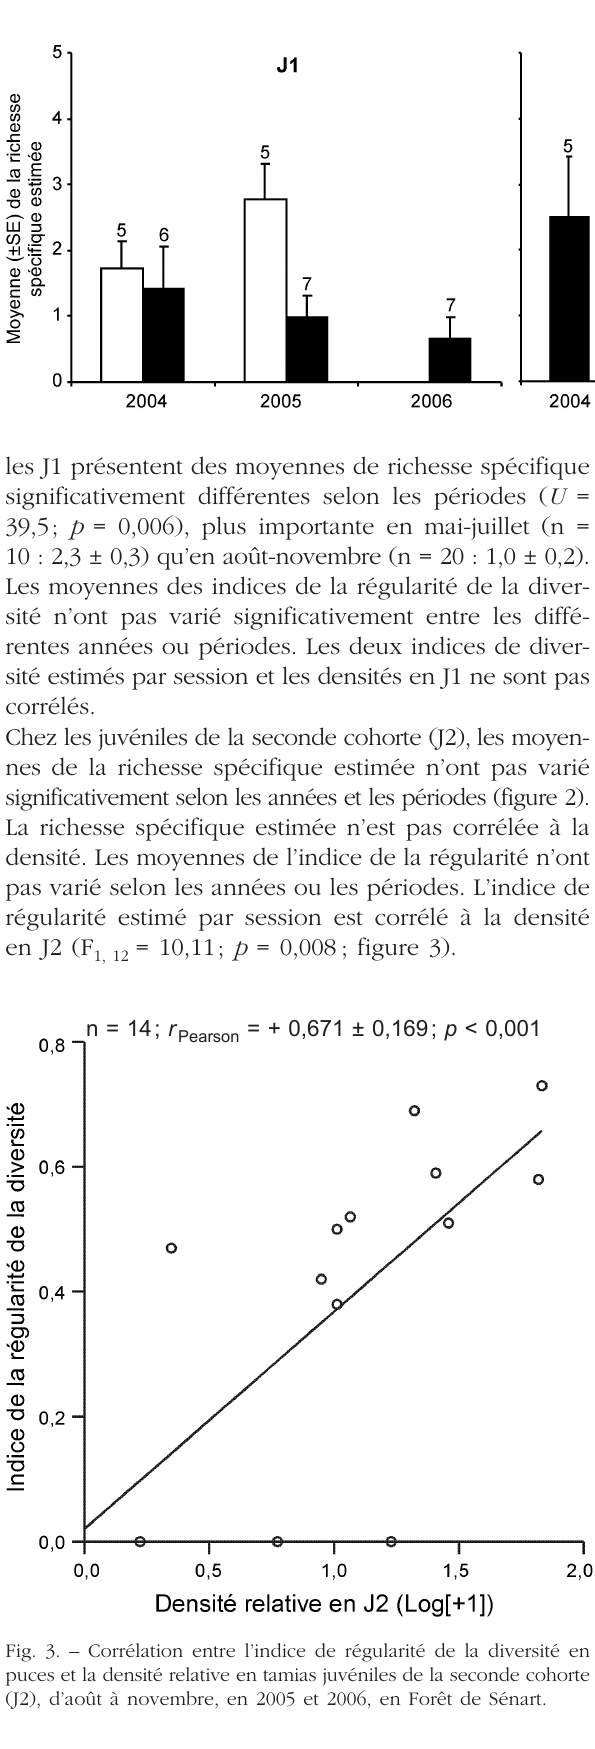
Fig. 3. – Corrélation entre l’indice de régularité de la diversité en puces et la densité relative en tamias juvéniles de la seconde cohorte (J2), d’août à novembre, en 2005 et 2006, en Forêt de Sénart.